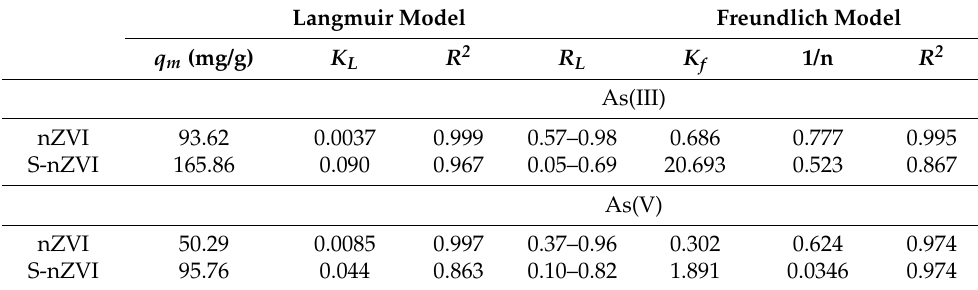
Table 2. Isothermal parameters of As(III) and As(V) adsorption on nZVI and